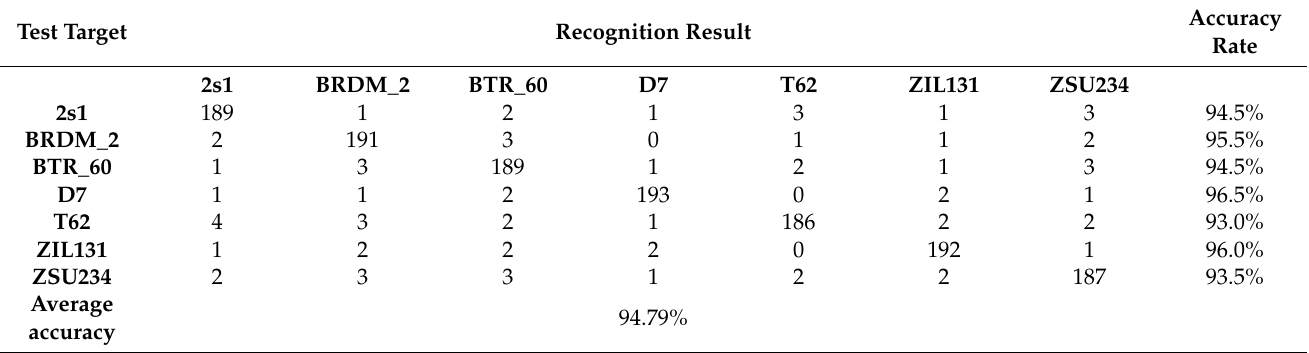
Table 8. Target recognition results (mixed targets dataset).